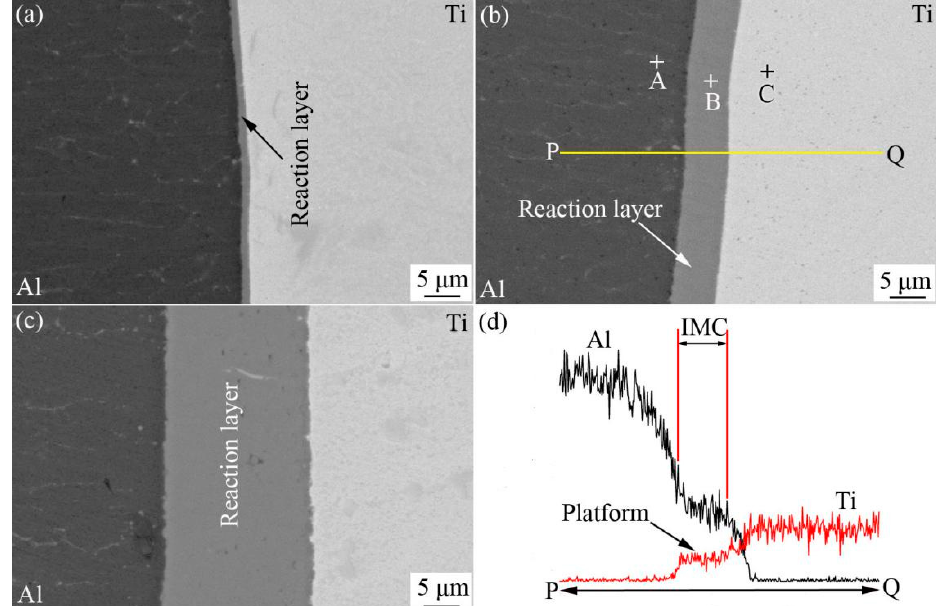
Figure 2. SEM images of the interfacial zone of samples annealed and EDX results; ( a ) annealing time 5 h, ( b ) annealing time 32 h, ( c ) annealing time 96 h, ( d ) EDX